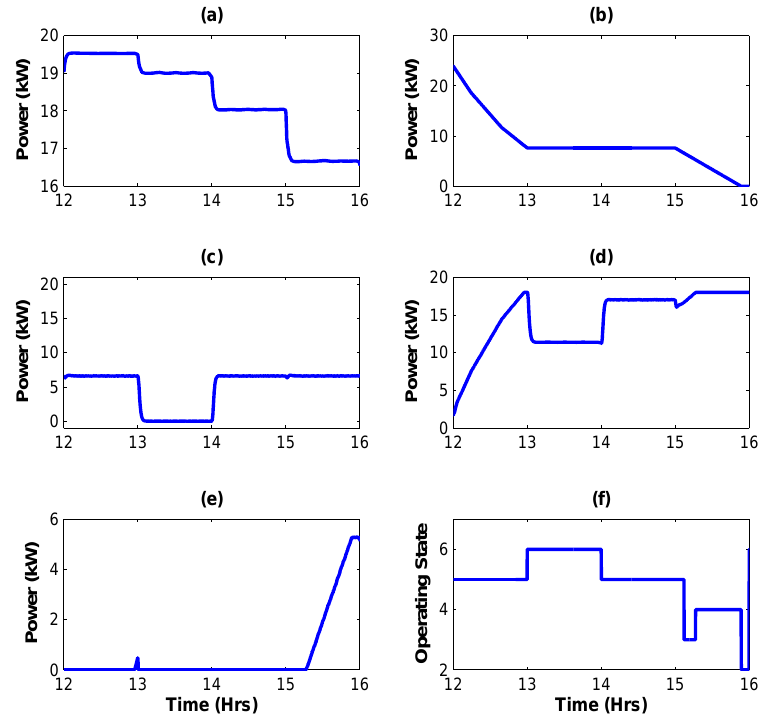
Figure 19. Simulation results for t = 12–16 h; ( a ) P DL , ( b ) P WT , ( c ) P CDi , ( d ) P NG , ( e ) P ES , ( f ) operating